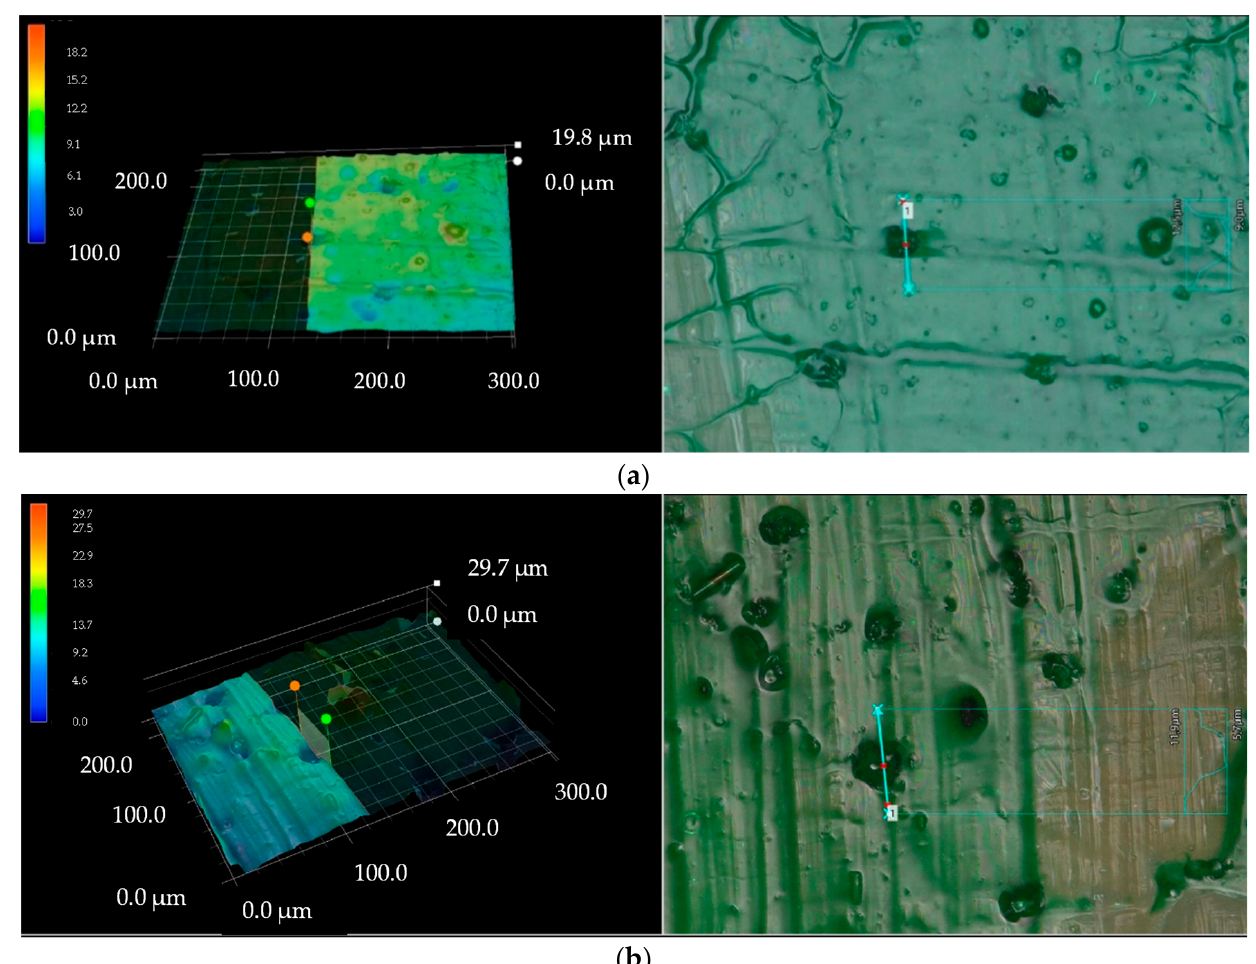
Figure 3. 3D images showing the existence of pinholes on the finished surface of glass-PTFE fabrics: ( a ) glass-PTFE type II, first batch (see Table 3) and ( b ) glass-PTFE type IV, first batch (see Table 3); taken by digital optical microscope (see Section 2.1.3).